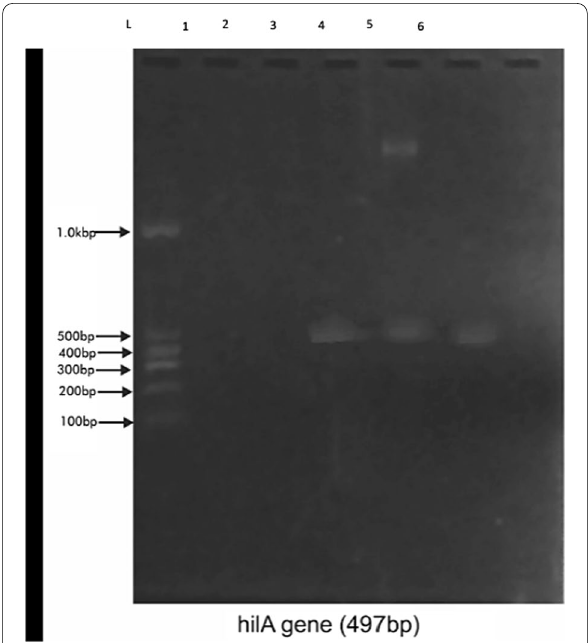
Fig. 3 PCR amplification of genomic DNA targeted to amplify the Hil A virulence factor embedded in Salmonella enterica serovar typhimurium on 1.0% agarose gel electrophoresis. L Marker. 1